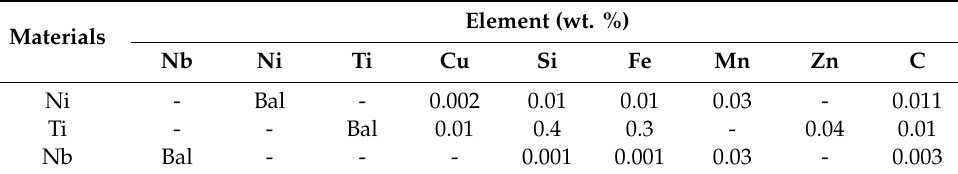
Table 1. Chemical composition of raw